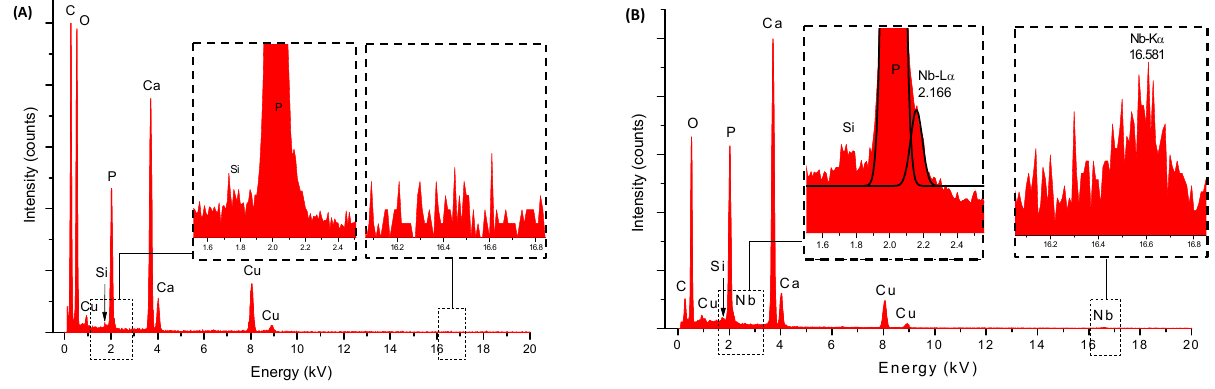
Figure 1. EDX spectra of HA_900 ( A ) and Nb-HA_900 ( B ).